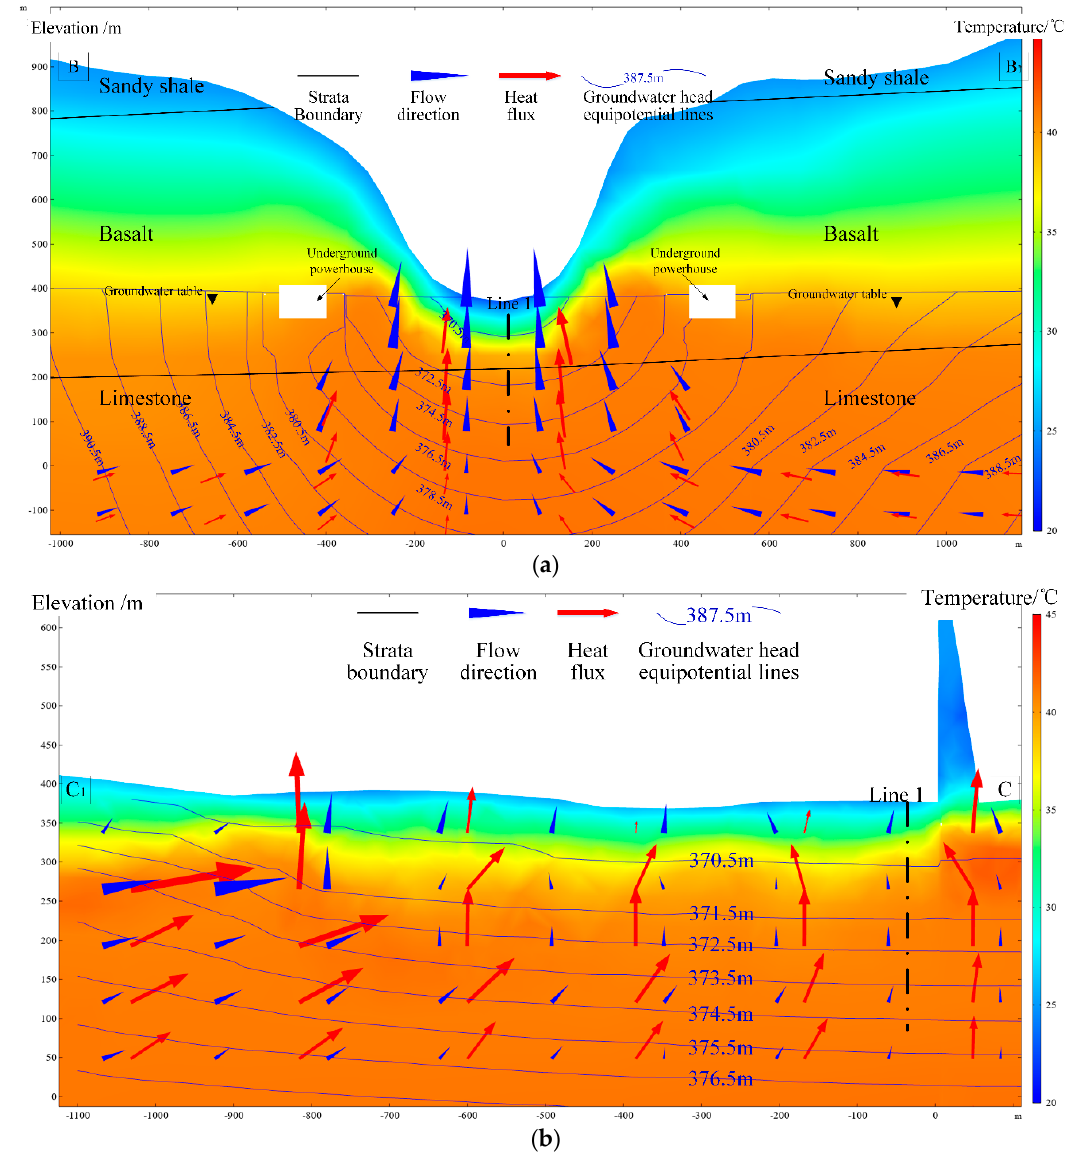
Figure 14. Thermal and seepage distribution before impoundment: ( a ) B–B1 section in Figure 13; ( b ) C–C1 section in Figure 13.